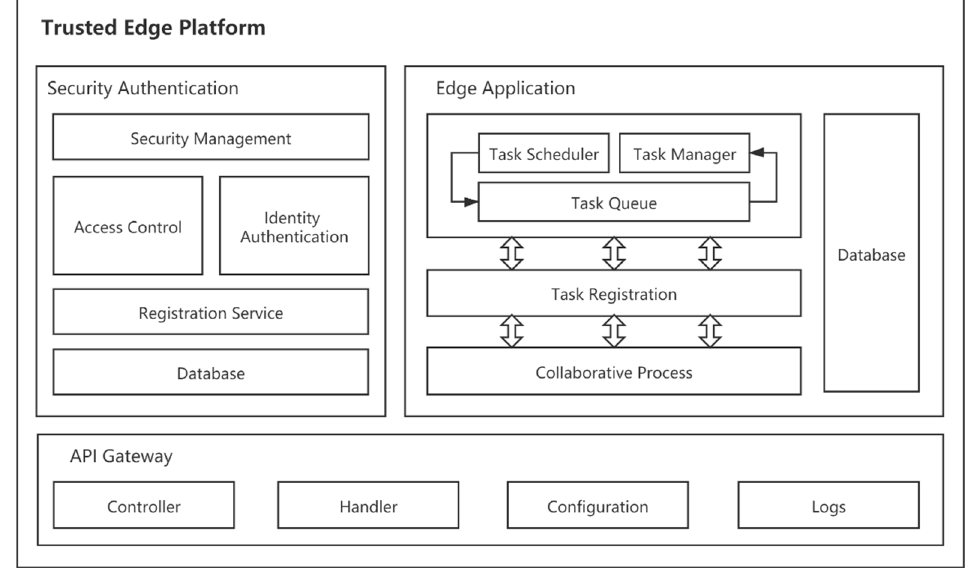
Figure 2. The architecture of the trusted edge platform.